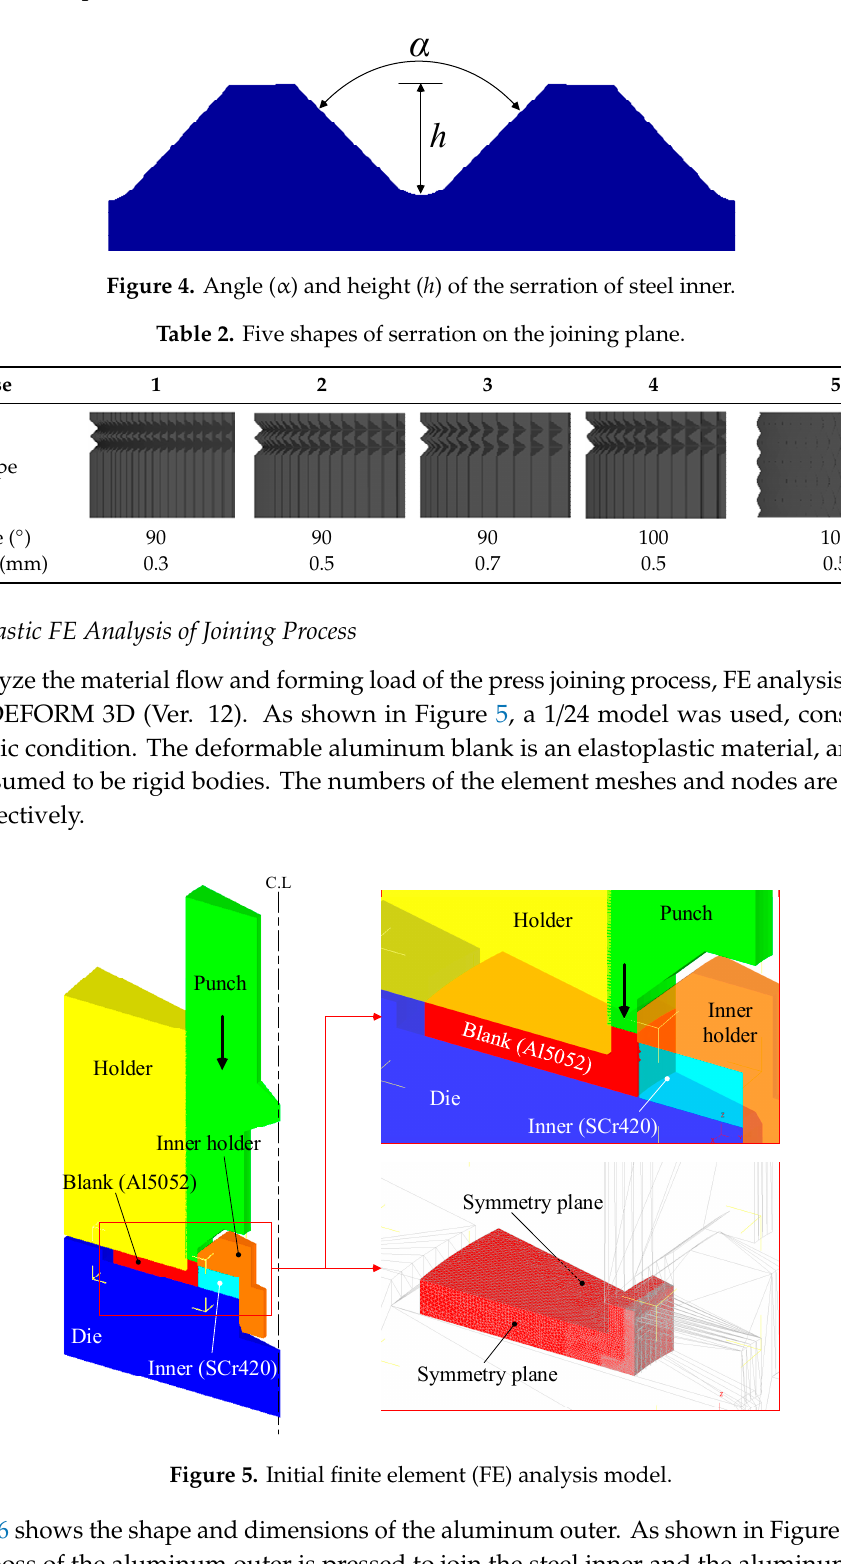
Figure 5. Initial finite element (FE) analysis model.